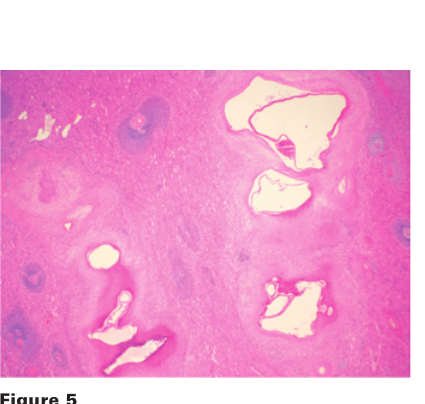
Figure 5 Microscopic aspect. Multiple cysts surrounded by eosinophilic and granulomatous necrosis and containing PAS-positive lamellae of chitin. Photo courtesy of Dr Brigitte Christen.